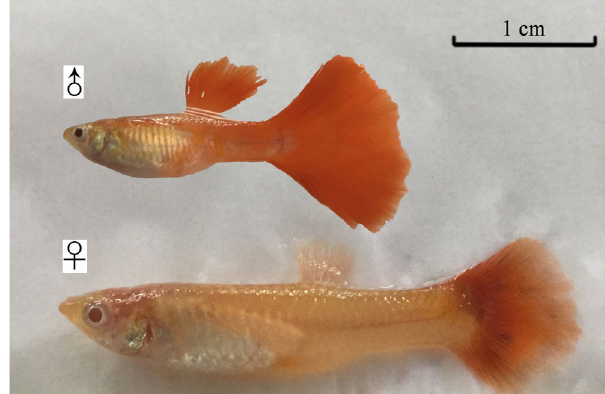
Figure 1. Photograph of male and female guppy ( Poecilia reticulata ).